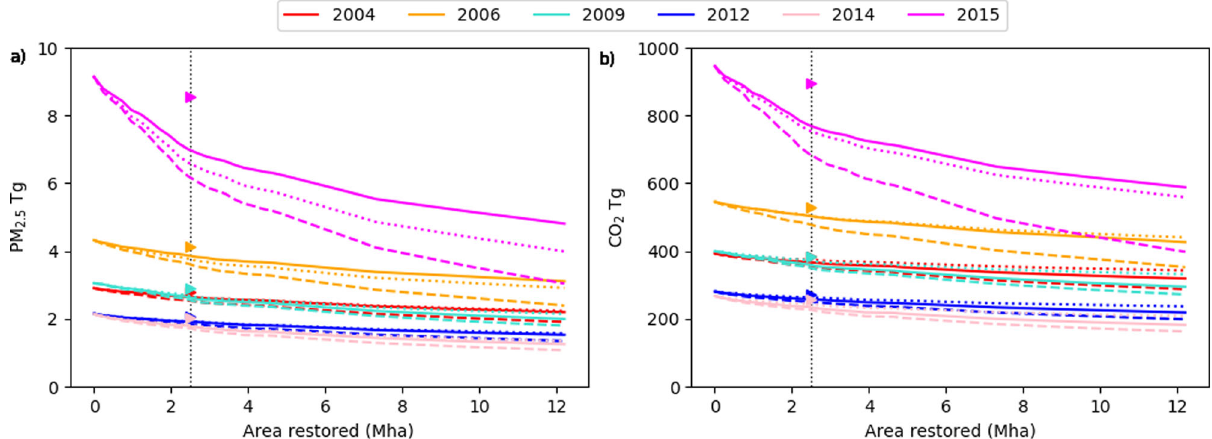
Fig. 4 Reduction in fi re emissions under peatland restoration scenarios. Emissions of PM 2.5 ( a ) and CO 2 ( b ) under different peatland restoration scenarios (National Parks: solid line, No peat fi res: dotted line and No fi re: dashed line). The triangles show the emissions when 2.49 Mha is randomly located, under the National Parks scenario. The black dotted vertical line shows 2.49